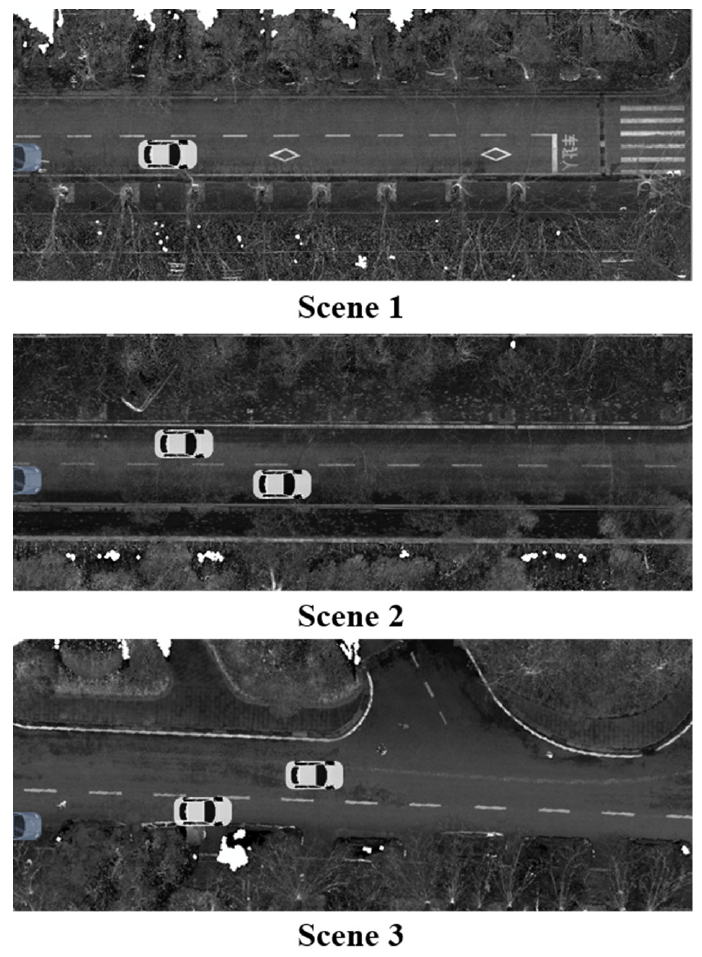
Figure 16. The scenes of the node optimization experiment.